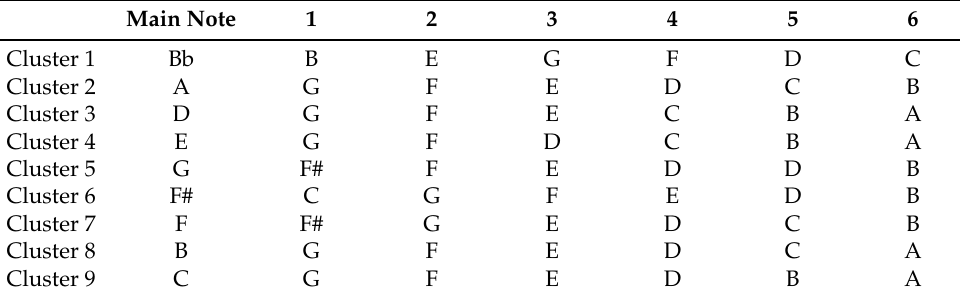
Table 2. The main note in the cluster and other